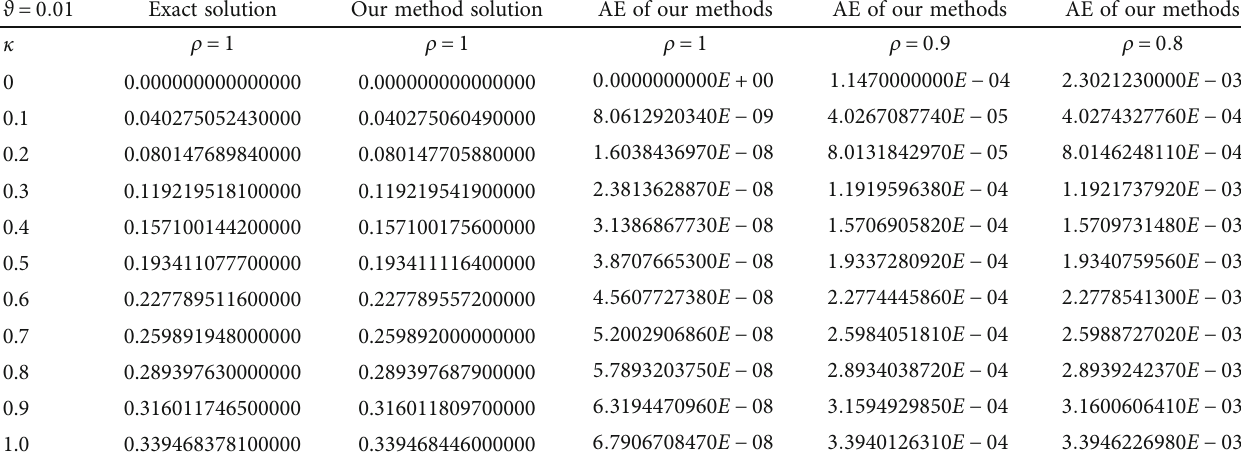
Table 3: Comparison of the exact and suggested method solution with the aid of absolute errors for problem 3.